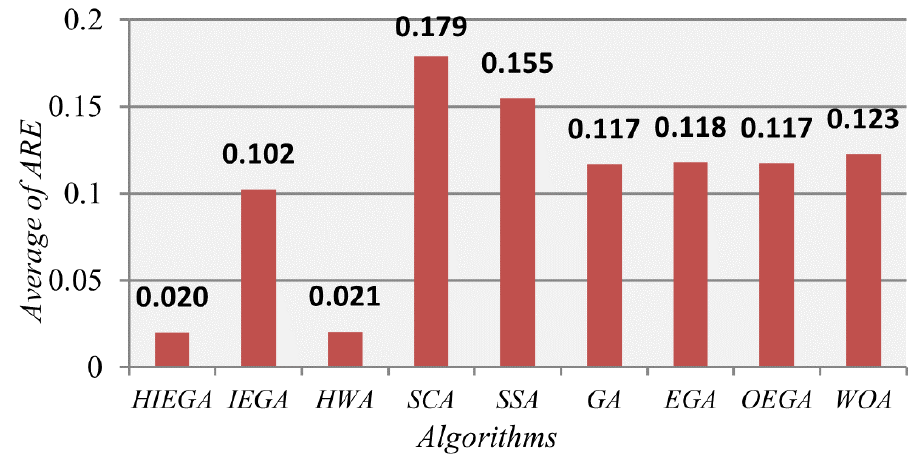
Figure 5. Comparison under the average of ARE on all the Reeve instances.